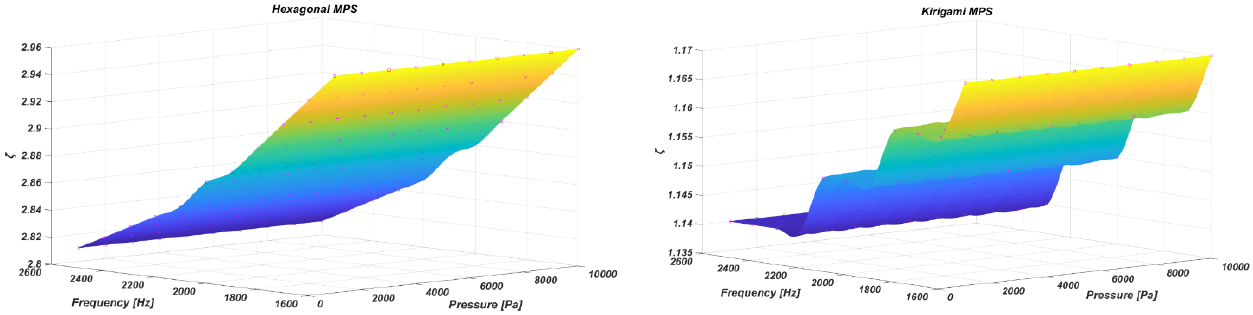
Figure 18. Distribution of the sensitivity gain factor for the hexagonal ( left ) and kirigami ( right ) MPSs.